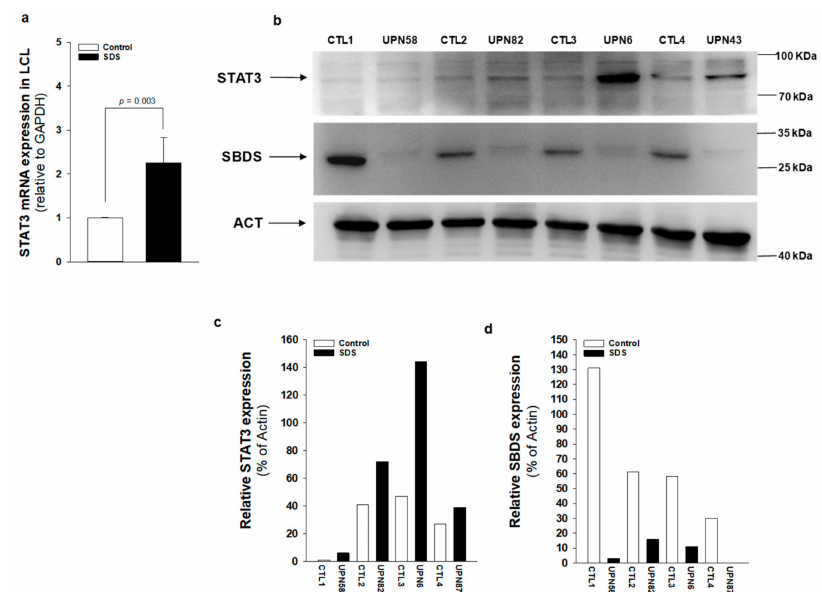
Figure 3. STAT3 transcript and protein expression is upregulated in SDS patient-derived LCL. ( a ) STAT3 mRNA expression in LCL isolated from UPN6, UPN43, UPN58, UPN82 (black bar), and from age-matched controls (white bar), measured by qRT-PCR. Data are mean ± SEM of four experiments performed in duplicate. ( b ) STAT3 protein level was measured in LCL (UPN6, UPN43, UPN58, UPN82) by Western blot analysis. ( c , d ) Densitometric analysis of Western blots showed in panel ( b ). Statistics: Normal distribution was tested by the Shapiro–Wilk test. Subsequently, the Mann–Whitney Rank Sum Test was calculated and reported within histograms.